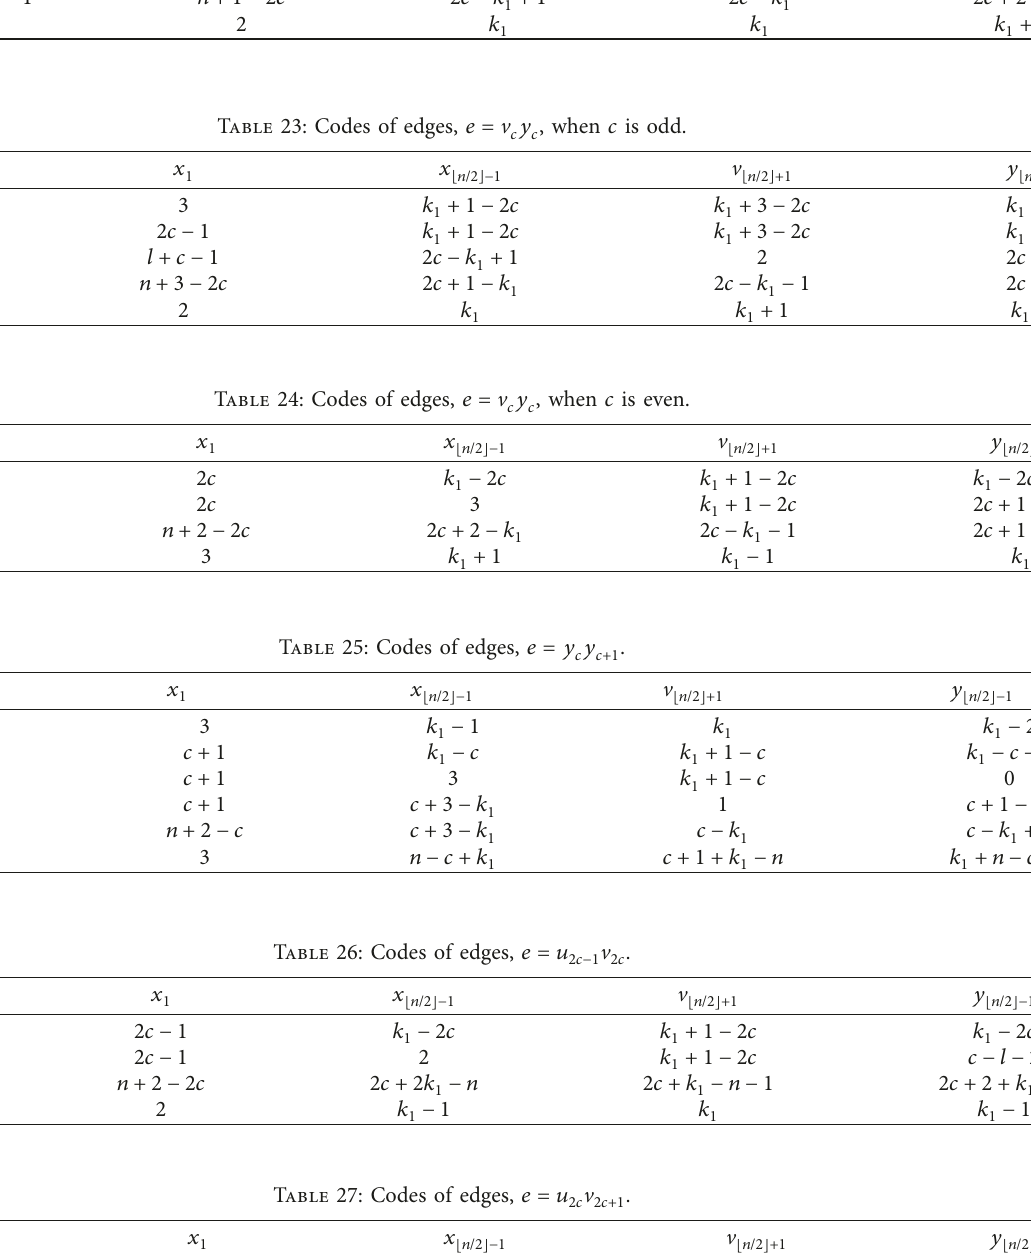
Table 27: Codes of edges, e � u